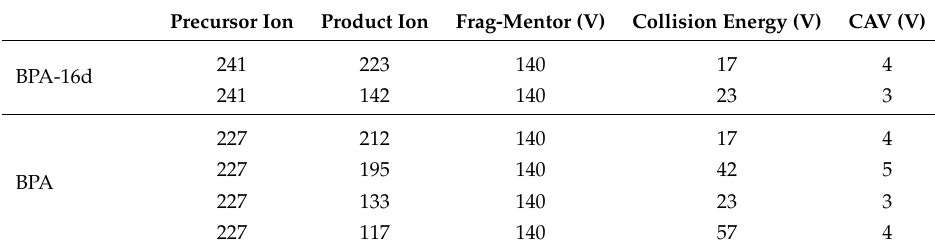
Table 5. MS parameters for quantification of BPA.